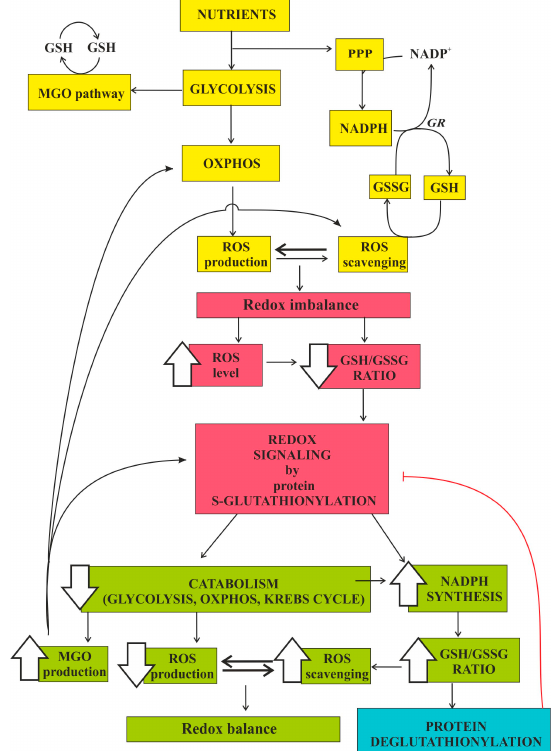
Figure 2. Nutrients can regulate cell metabolism through protein S-glutathionylation-mediated redox signaling. The interconnection between nutrient metabolism, oxidative stress/redox imbalance, and methylglyoxal (MGO) formation and metabolism is schematically represented. Yellow boxes indicate normal nutrient catabolism, which induces ROS production balanced by ROS scavenging. Red boxes indicate a condition of redox imbalance that induces redox signaling through protein S-glutathionylation. Green boxes indicate the metabolic changes that underly cell response to oxidative stress, leading to the restoration of both the redox balance and normal nutrient metabolism via protein deglutathionylation (light blue box). The increase of the MGO level occurring under oxidative stress conditions and its involvement in redox signaling, ROS scavenging, and ATP production via OXPHOS (see Figure 1) are also schematically indicated.